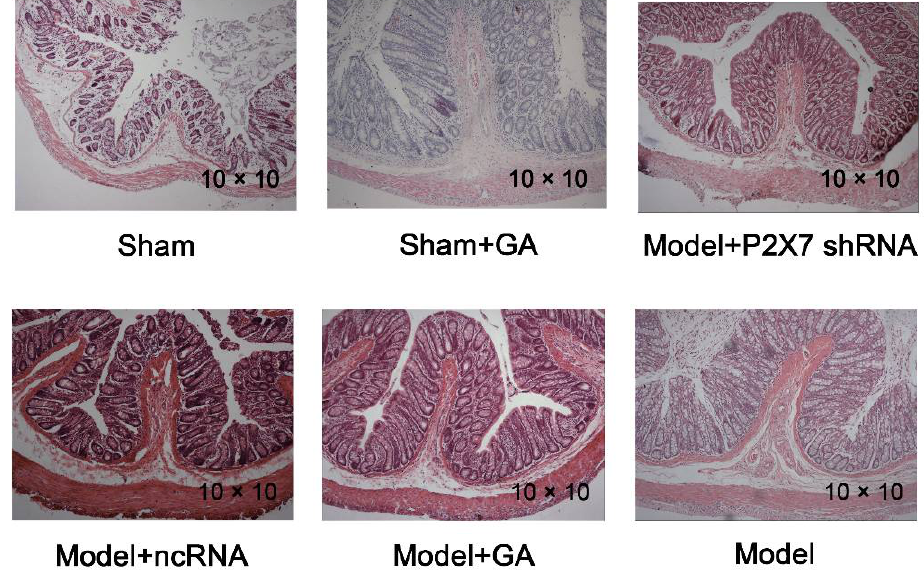
Figure 4. H&E staining of rat rectum tissues from each group under 100× field of view.